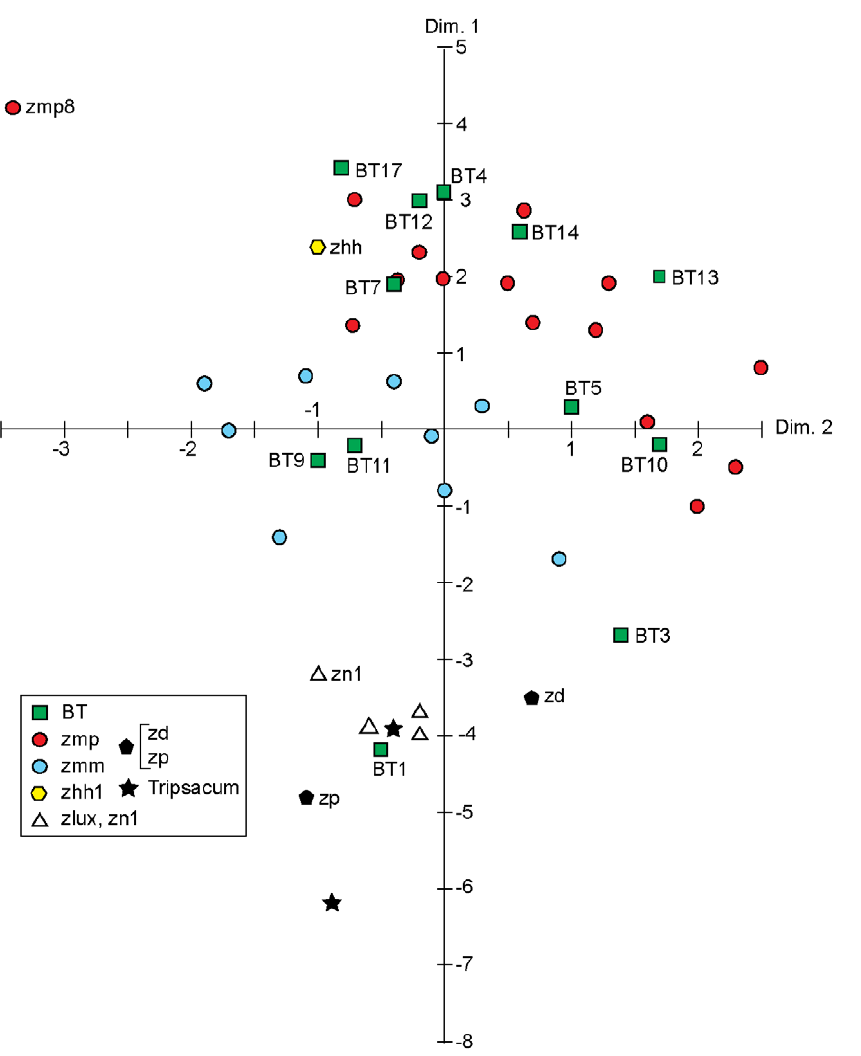
Figure 2. Metric Multidimensional Scaling (MDS) of unstandardized Euclidean distances based on 45 rondel classes, dimensions 1 and 2. Dimension 1 accounts for 65% of trace, dimension 2, 14%. Samples coded for teosinte taxa, with BT=Blind Test, Tripsacum=Tripsacum.